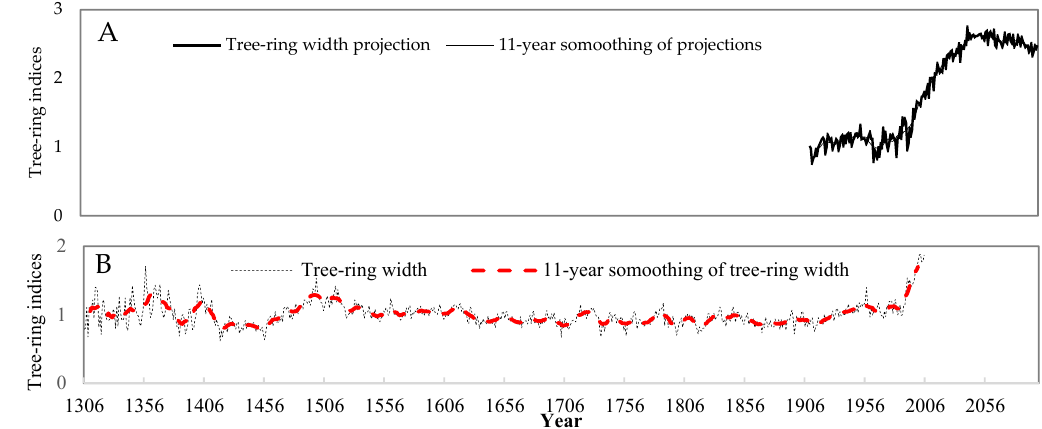
Figure 9. Regional mean tree ‐ ring chronology projection from 2006 to 2100 under RCP 2.6 ( A ) and regional mean tree ‐ ring indices from 1306 to 2005 ( B ).